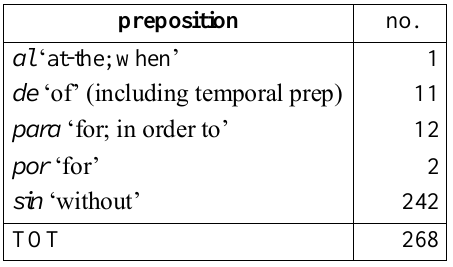
Table 2: Analyzed data with respect to the type of introducing preposition preposition no. al ‘at-the; when’ 1 de ‘of’ (including temporal prep) 11 para ‘for; in order to’